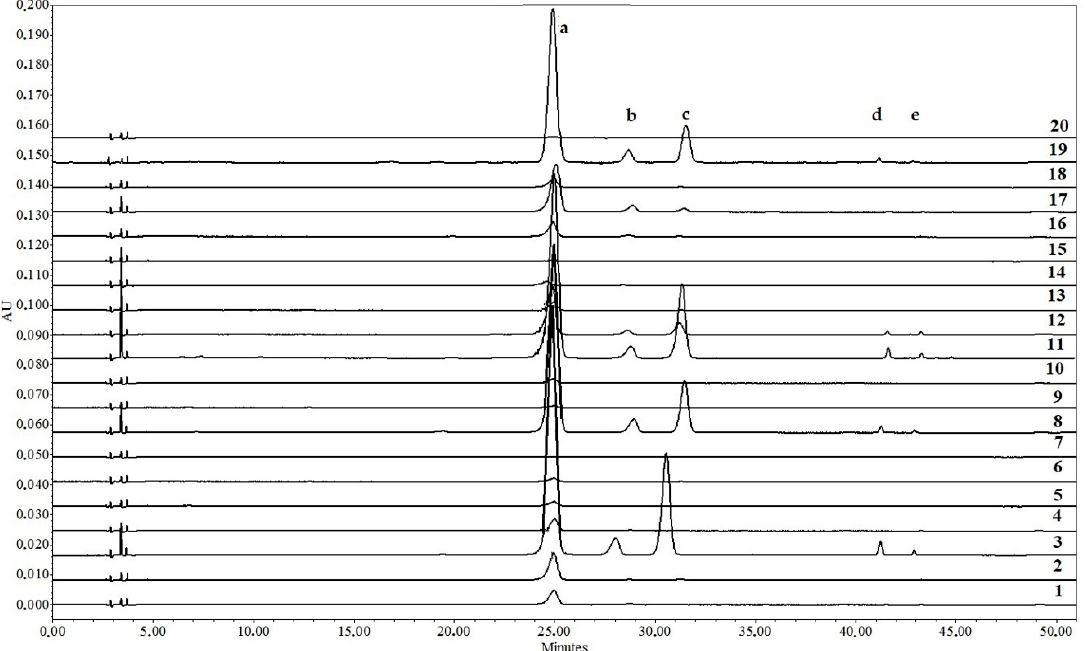
Figure 2. Anthocyanin compound profiles of different Sorbus fruit powder samples. a—cyanidin 3- O -